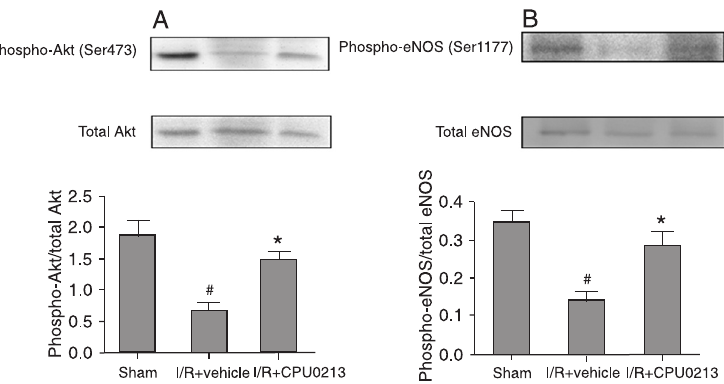
Figure 6. Representative Western blots showing ( A ) phospho-Akt (protein kinase B; Ser473) and total Akt and ( B ) phospho-eNOS (endothelial nitric oxide synthase; Ser1177) and total eNOS in ischemic myocardial tissues after ischemia-reperfusion. Quantitative densitometry data are reported as means ± SEM for 4 rats/group. # P < 0.05 vs Sham; *P < 0.05 vs I/R + vehicle (one-way ANOVA with the Bonferroni post hoc